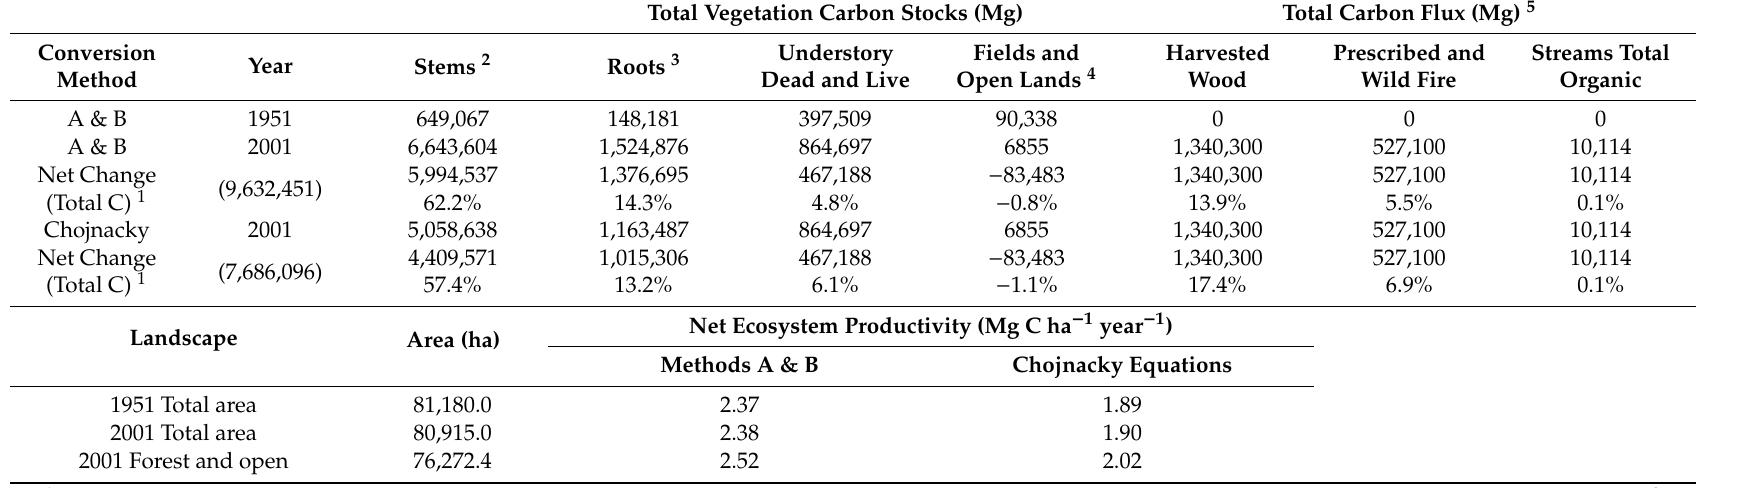
Table 5. The net ecosystem productivity was determined for the period from 1951 to 2001. The total aboveground tree biomass (i.e., stems) was determined as the average value of Methods A and B for the conversion of growing stock in 1951. The total aboveground tree biomass (i.e., stems) in 2001 was determined using the average of Method A and B, and the national biomass estimator equations [36] separately. Values of the biomass converted to C using a factor of